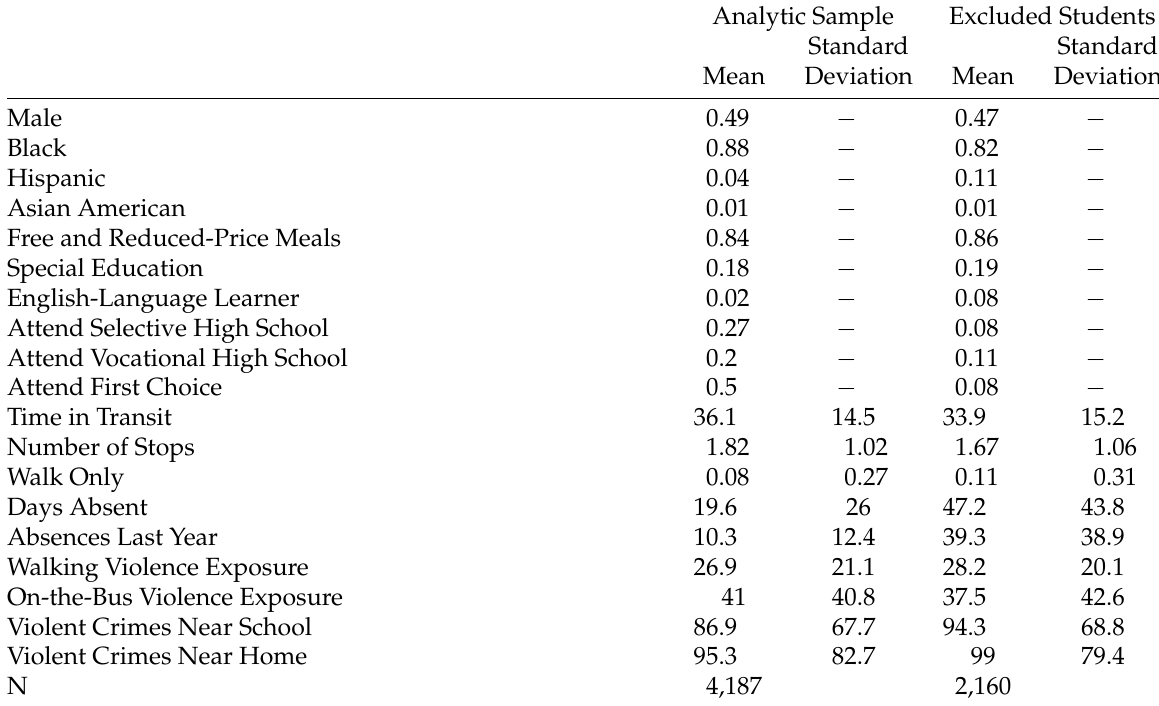
Table 1: Characteristics of students and their